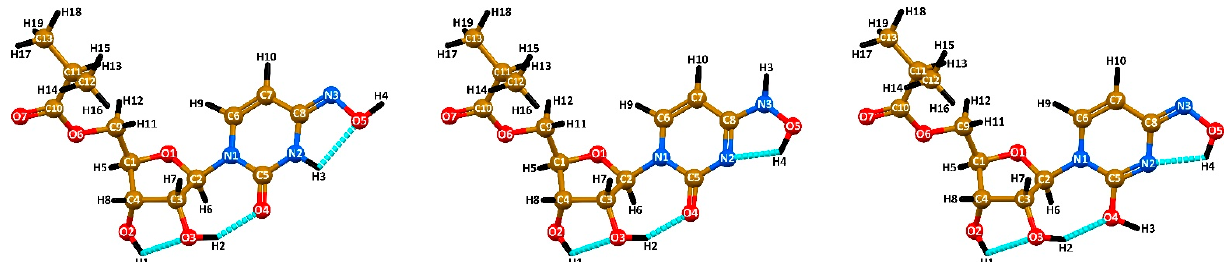
Figure 3. Optimized structures of the keto-oxime (left), keto-hydroxylamine (middle), and hydroxyl-oxime (right) tautomers of molnupiravir, obtained by using the B3LYP/6-311++G(d,p) method. Cyan dashed line = O–H ∙∙∙ O, O–H ∙∙∙ N and N–H ∙∙∙ O hydrogen bonds. Table 3. Hydrogen bond lengths (Å) and angles (°) in the optimized structures of the keto-oxime, keto-hydroxylamine and hydroxyl-oxime tautomers of molnupiravir, obtained by using the DFT/B3LYP/6-311++G(d,p) method.